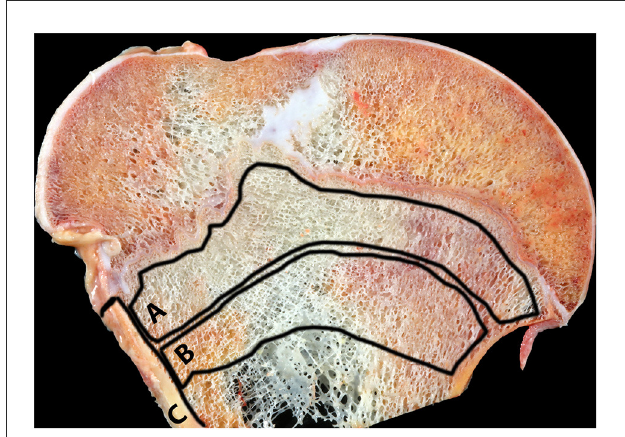
FIGURE1 Humeral bone slab, affected cow, proximal humerus. The three locations selected for spectroscopic analysis are shown. A, primary spongiosa; B, secondary spongiosa; C,